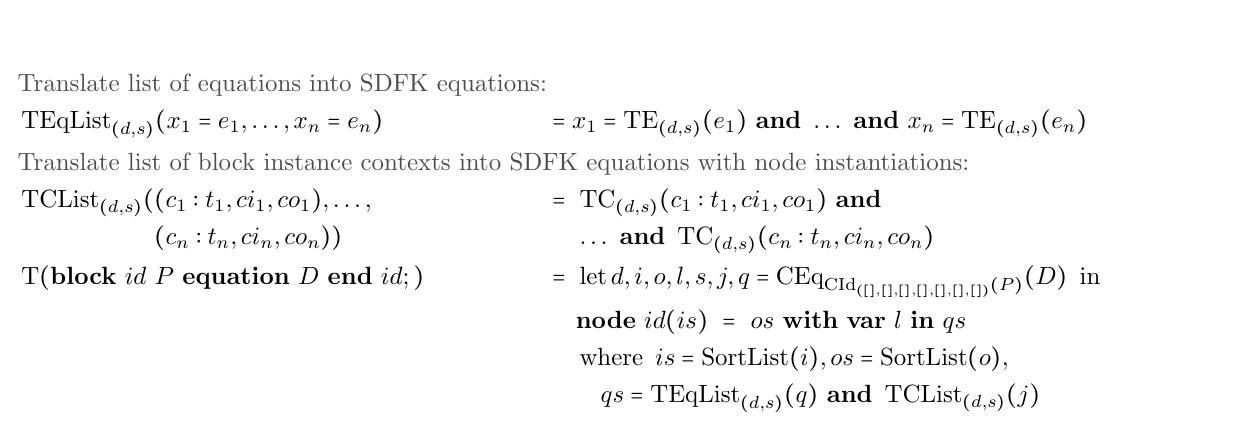
Figure 3: Translation from the normalized mACG-Modelica language into the SDFK language. The translation